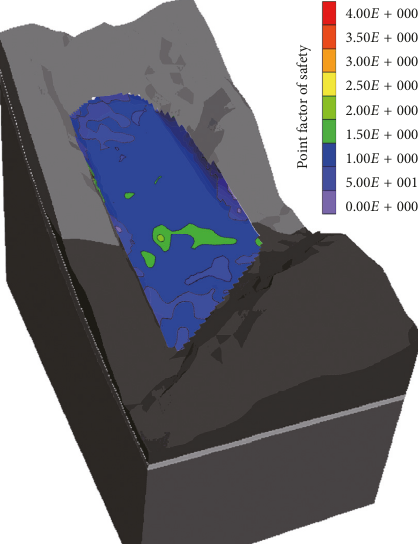
Figure 10: Distribution of factor of safety after impounded.